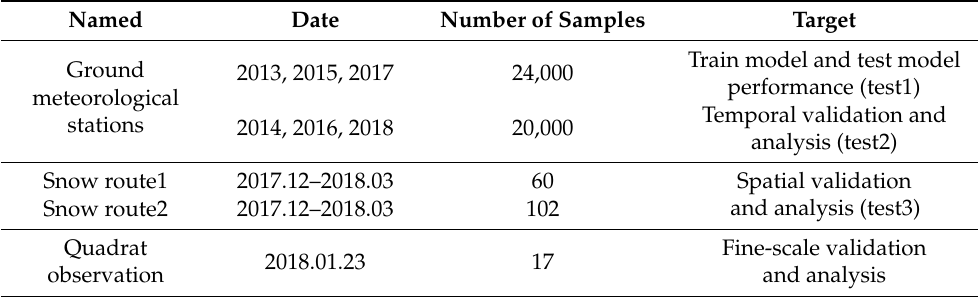
Table 1. Three ground observation